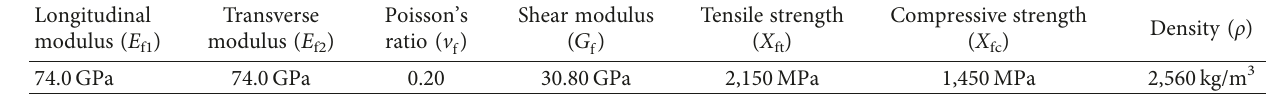
Table 1: Mechanical properties of E-glass fibers [19].